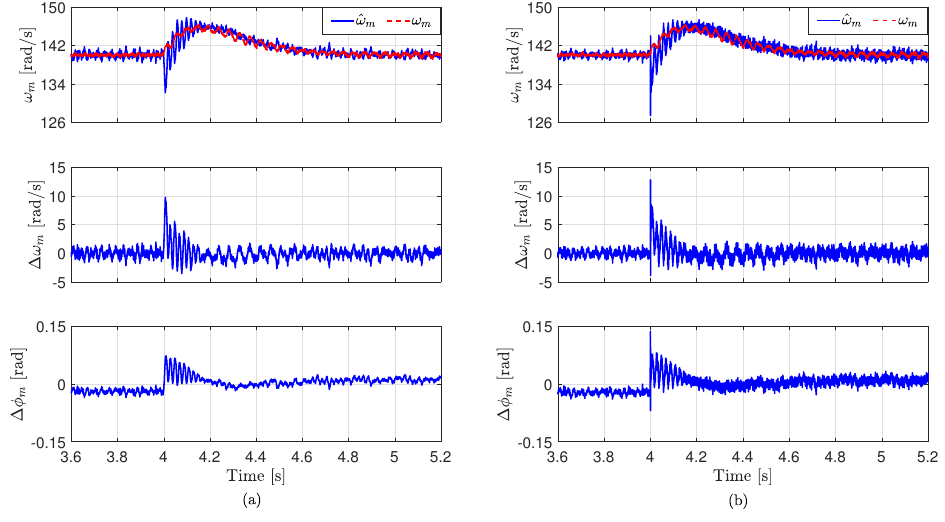
Figure 6. Experimental results at variations of the electro-magnetic torque of the DFIG T ∗ e : ( a ) LPS-MRAO, and ( b ) traditional